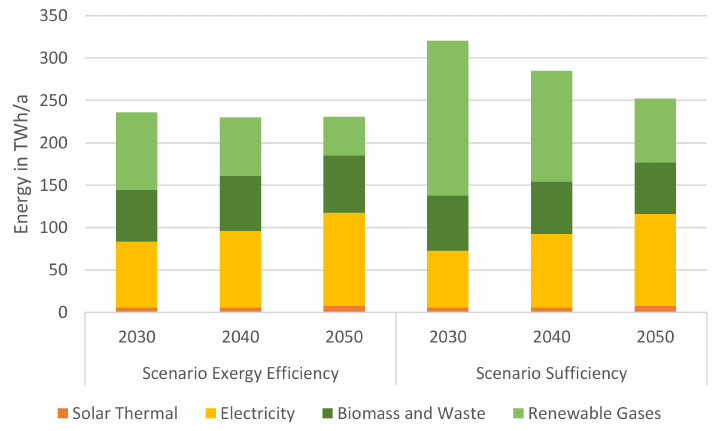
Figure 3. Comparison of the primary energy consumption for both scenarios and all considered